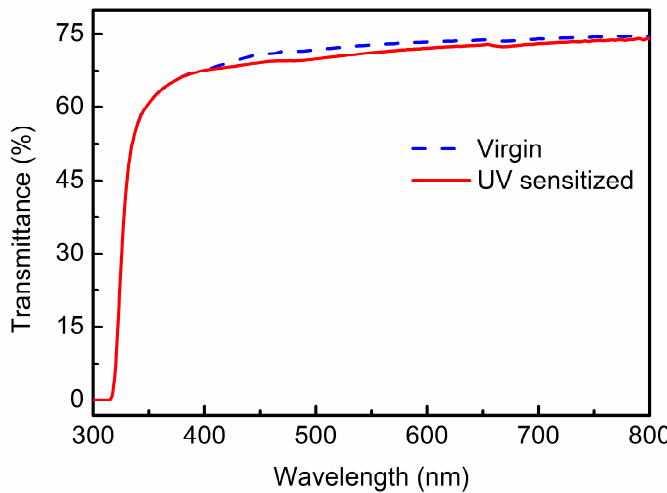
Figure 7. Transmittance of CLN 100 before and after sensitization by an A400 mercury lamp with wavelengths centered at 365 nm.